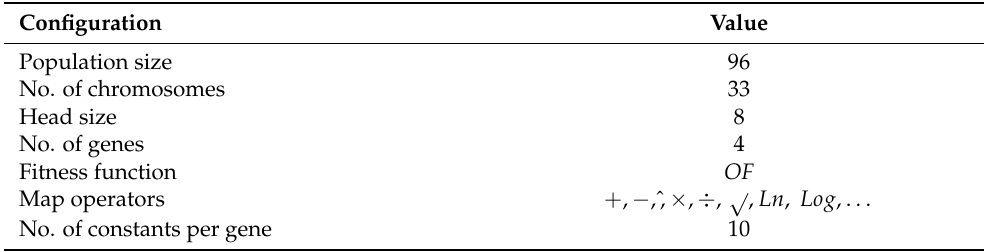
Table 5. The optimal GEP parameters.